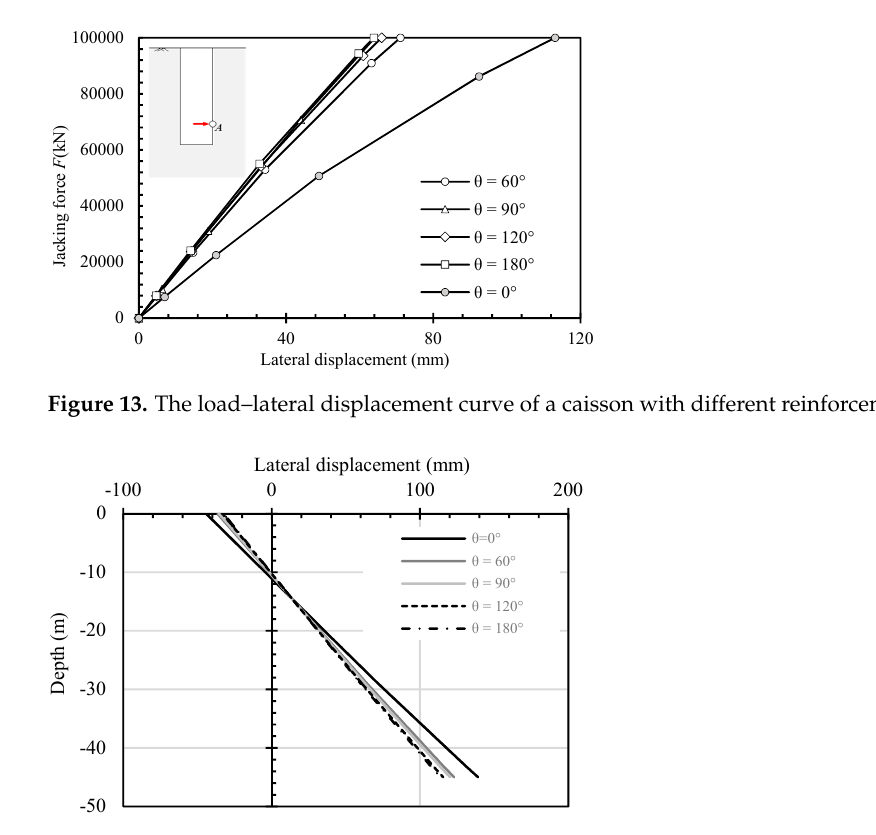
Figure 14. The distribution curve of lateral displacement along the depth of a caisson with different reinforcement angles.